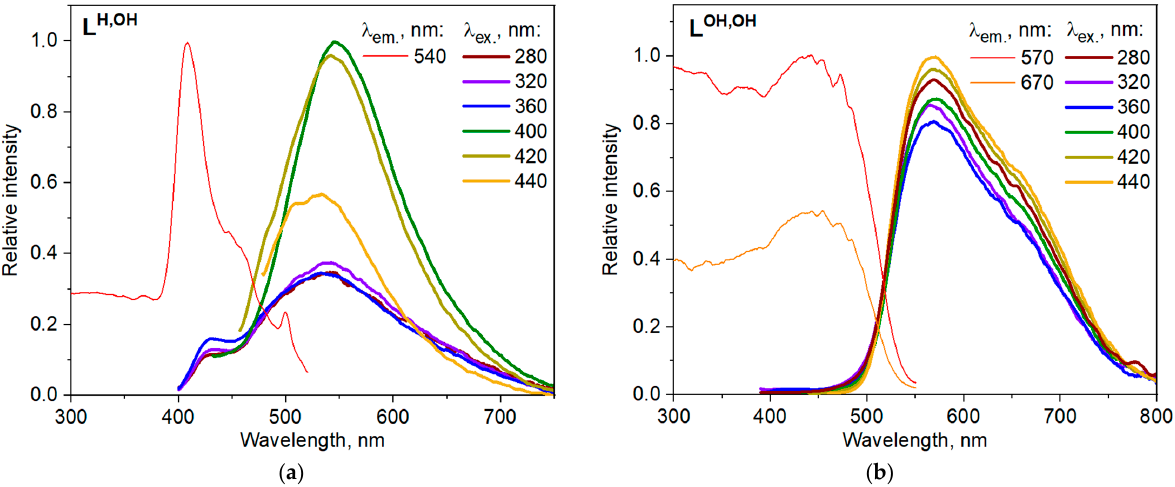
Figure 6. Excitation and emission spectra of L H,OH ( a ) and L OH,OH ( b ) in the solid state at room temperature.